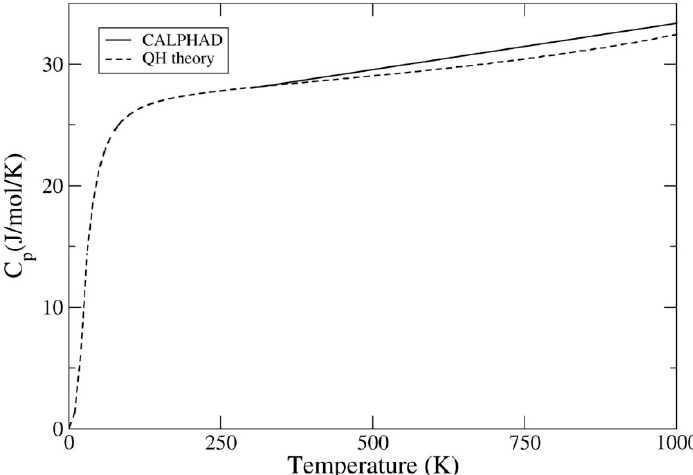
Figure 3. UI 3 specific heat at constant pressure, Cp (J / mol / K), calculated from our DFT-quasi-harmonic (QH) model and from the SSUB6 CALPHAD database.